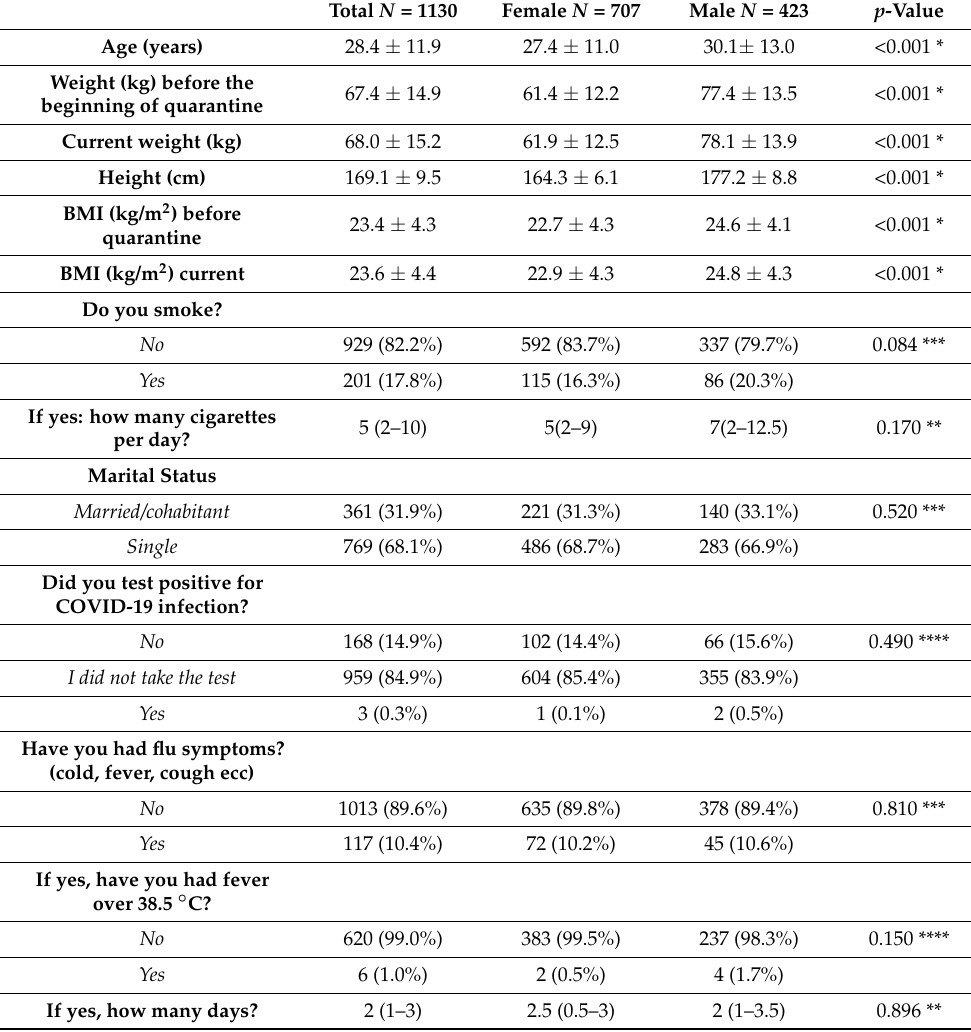
Table 1. Characteristics of the university population and stratification by